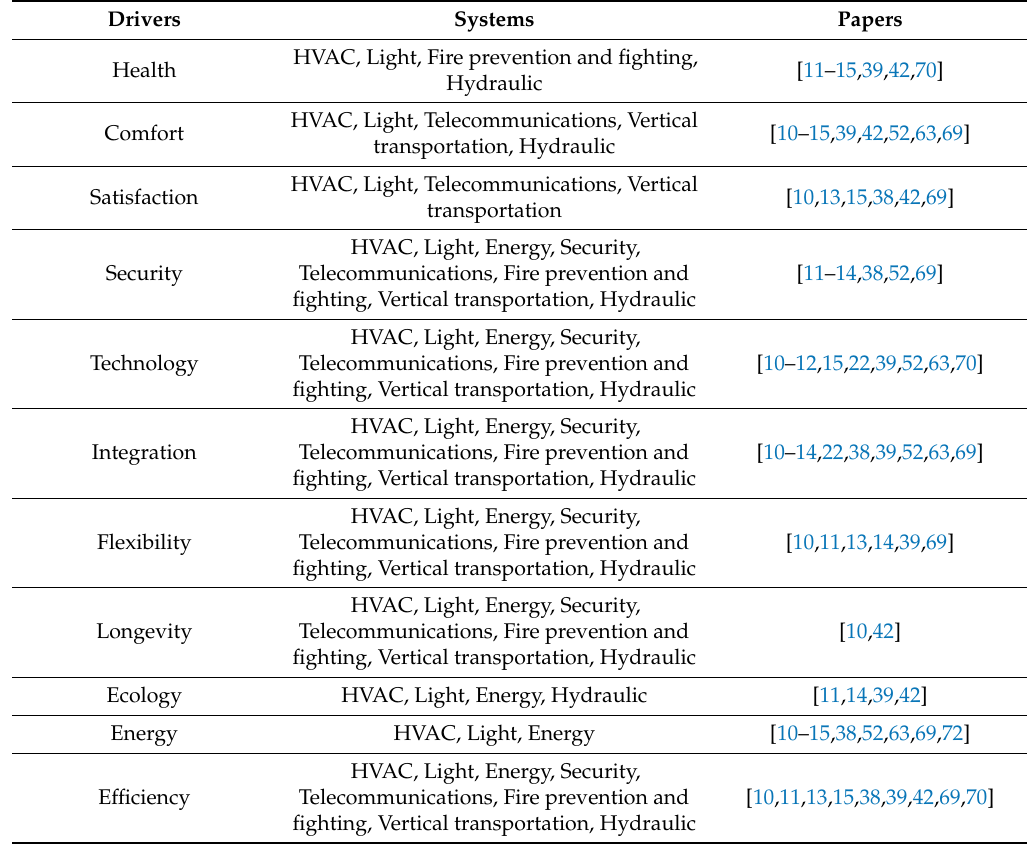
Table 3. Relationships between drivers and systems, based on our view of the searched articles.